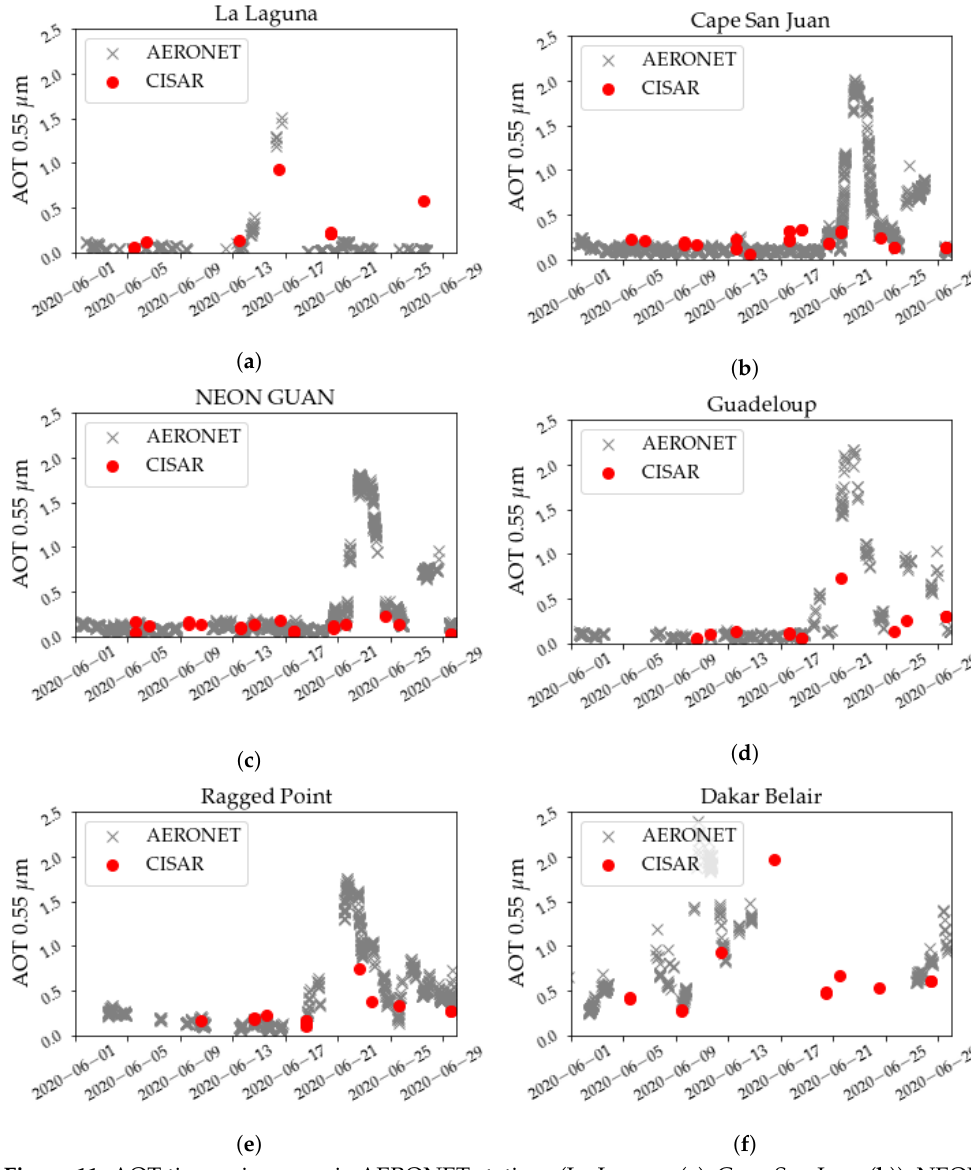
Figure 11. AOT timeseries over six AERONET stations (La Laguna ( a ), Cape San Juan ( b )), NEON GUAN ( c ), Guadeloup ( d ), Ragged Point ( e ), and Dakar Belair ( f ) affected by the Godzilla dust storm. Figure 11 evaluates the retrieval of the AOT at 0.55 µm against AERONET